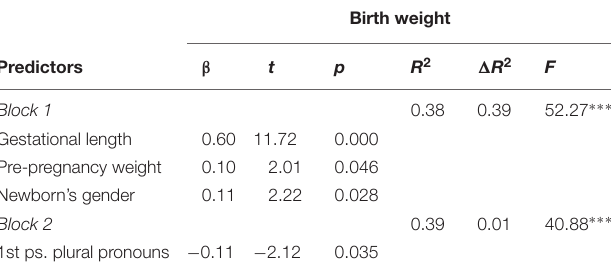
TABLE 4 | Block-wise regression analysis for neonatal birth weight. TABLE 5 | Block-wise regression analysis for neonatal birth